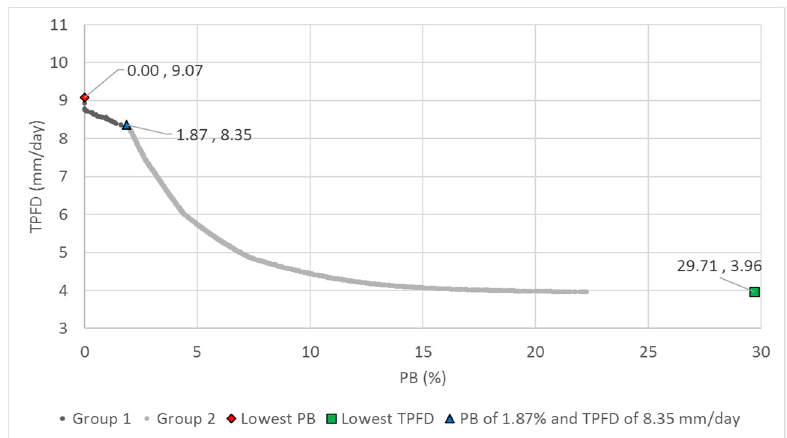
Figure 10. Global Pareto front region covered by Groups 1 and 2 with three selected solutions for the hydrograph: Group 1 has two quick flow tanks ( n = 2, normalized n = 0.5), and Group 2 has a single quick flow tank ( n = 1). Water 2017 , 9 , 187